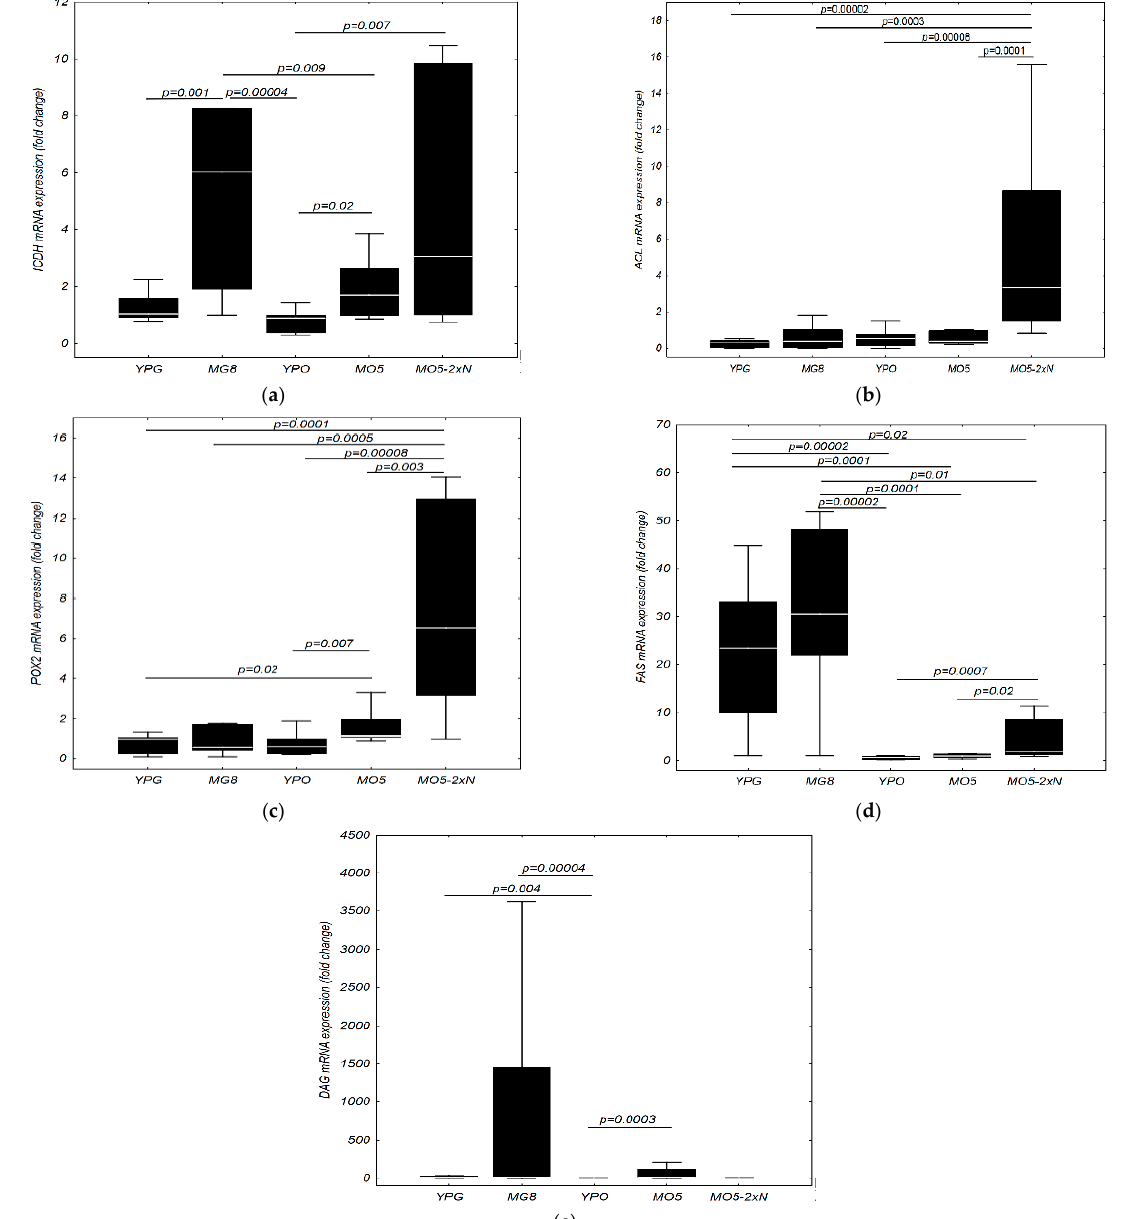
Figure 7. Average expression of the ICDH ( a ), ACL ( b ), POX2 ( c ), FAS ( d ), DAG ( e ) mRNA in yeast cells of Y. lipolytica KKP 379 during batch cultures in control YPG and YPO medium, MG8 (containing glucose) and MO5 and MO5-2xN (containing olive oil) media during 84 h culture. The results are presented as the median (line), the percentile range (frame) and the range of minimum—maxi- mum.